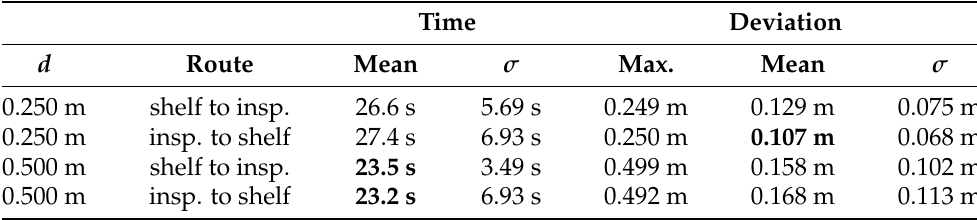
Table 1. Results of the